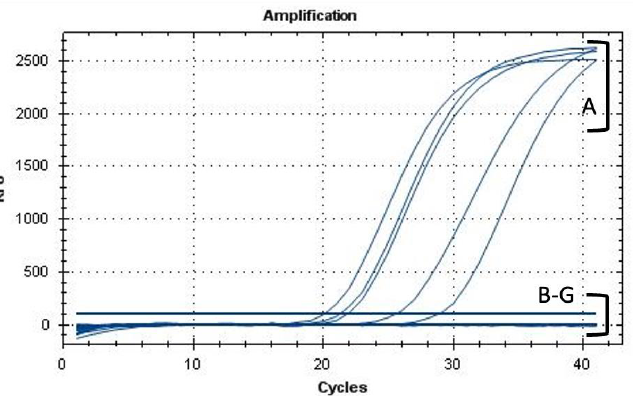
Figure 9. qPCR assay showing DNA amplification curves obtained from (A) Xf- infected tobacco plants untreated with AMPs (positive controls); Xf- infected tobacco plants treated with (B) NAC, (C) KL29, (D) GF19, (E) FF13, and (F) IL14; and (G) uninfected tobacco leaves used as a negative control.